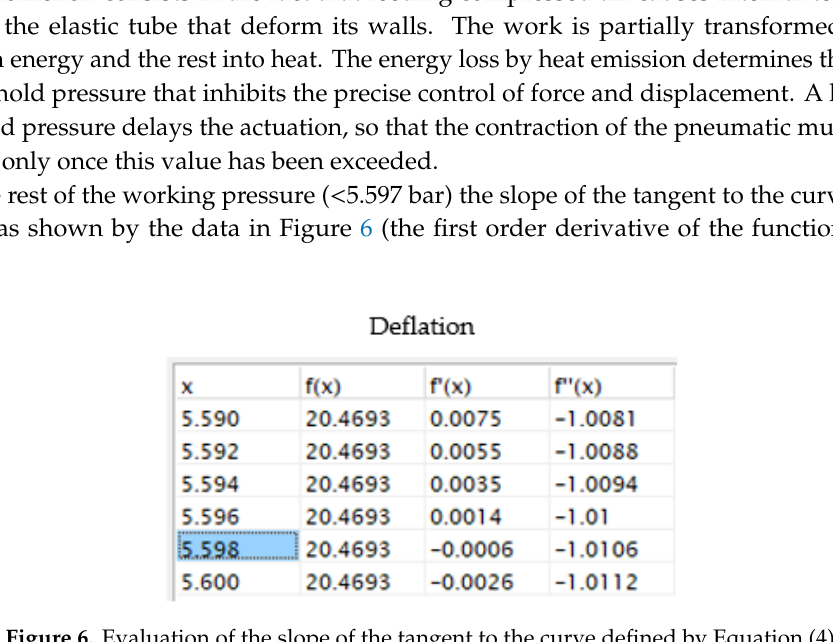
Figure 6. Evaluation of the slope of the tangent to the curve defined by Equation (4).